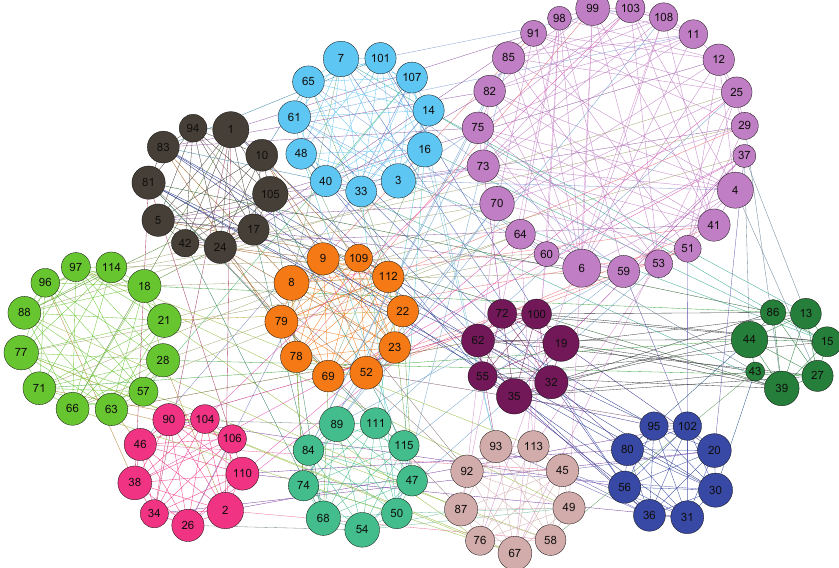
Figure 4. The final community structure of Football according to the NINS